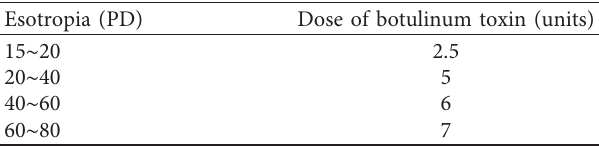
Table 1: Botulinum toxin dosage. Esotropia (PD) Dose of botulinum toxin